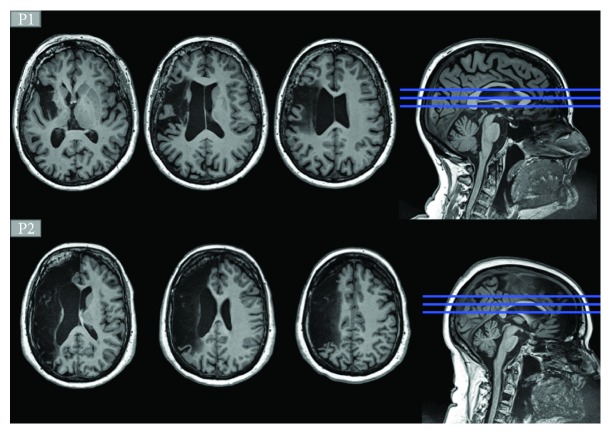
Lesion location on anatomical MRI for P1 (top three slices) and for P2 (bottom three slices).